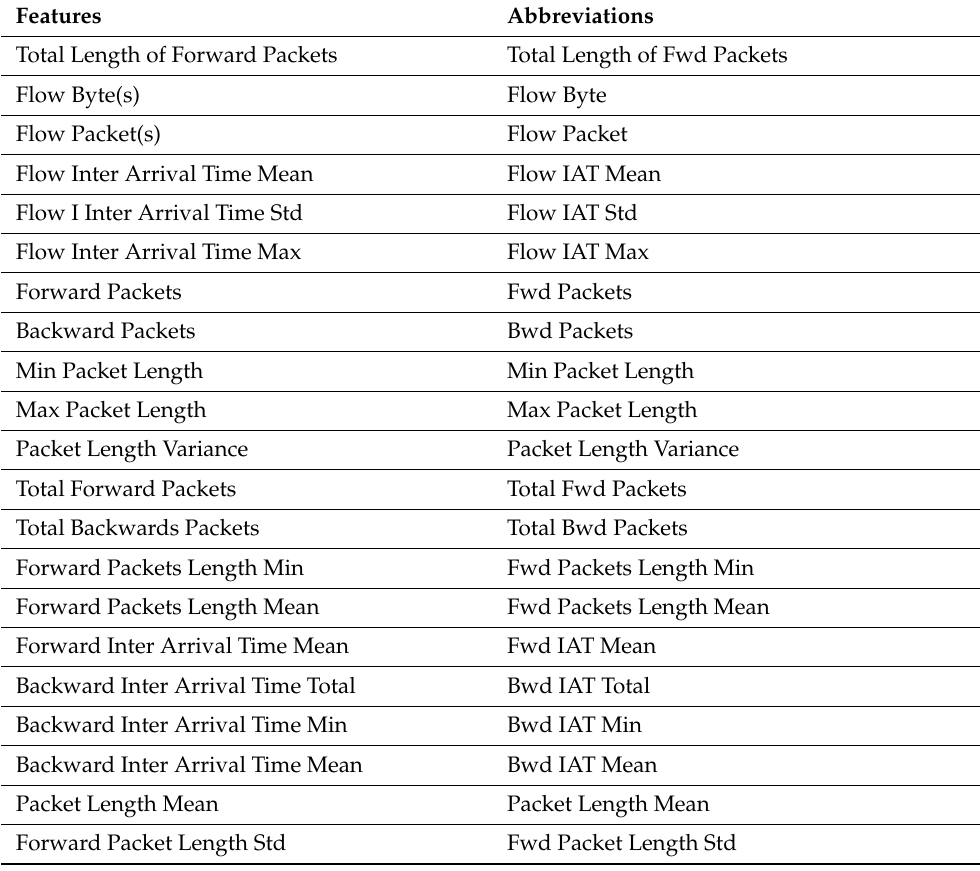
Table 2. List of Selected